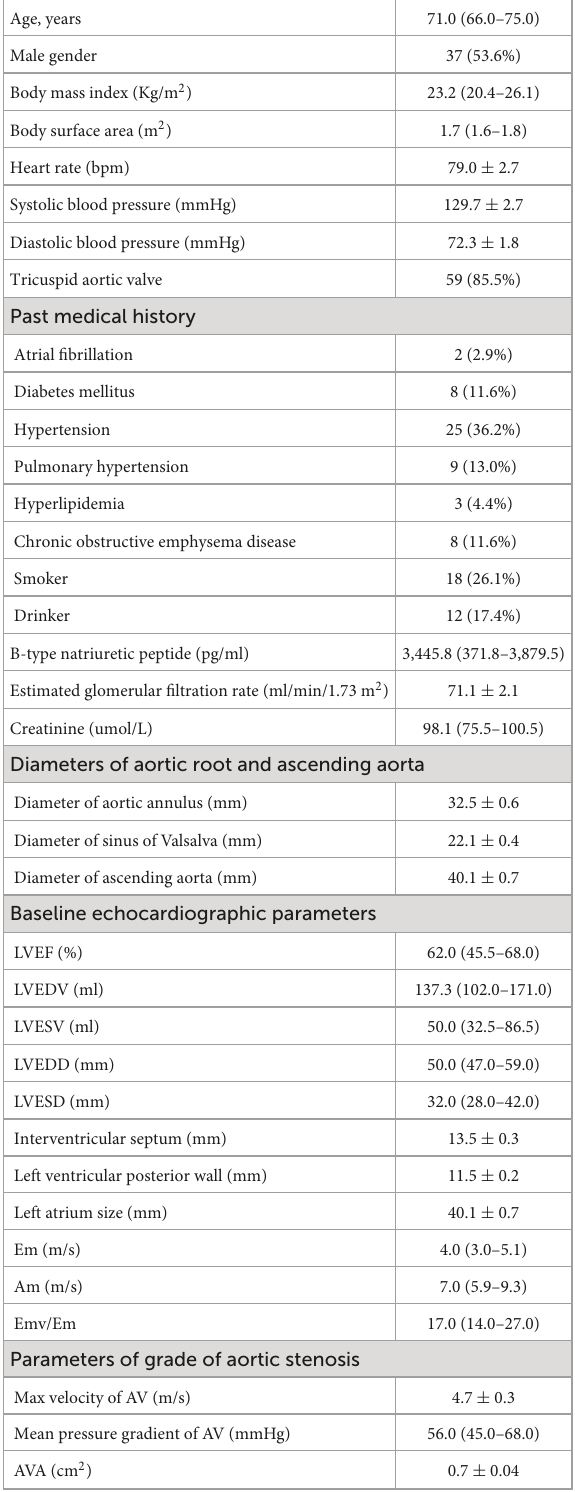
TABLE 1 Clinical characteristics and echocardiographic parameters of the study